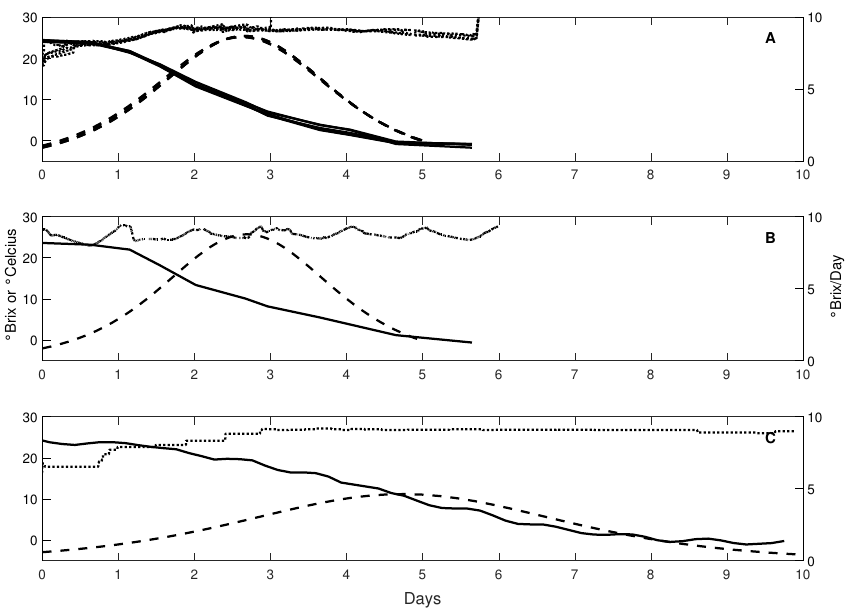
Figure 7. Fermentation curves (°Brix, -) and rates (°Brix/Day, - -) and temperatures (°C, ·· ) across scales of 100 L (( A ), 5 fermentations), 1500 L (( B ), 1 fermentation) and 10,000 L (( C ), 1 fermentation).